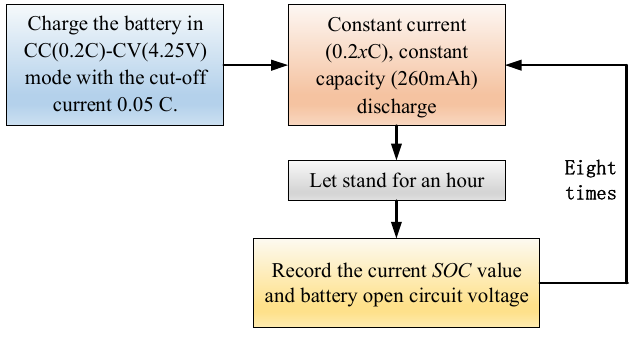
Figure 4. Calibration steps of the OCV-SOC . The corresponding relationships between OCV and SOC were recorded for x = 2, 3, 4, 5, 6, 7.5, 10, respectively. Figure 5 shows the different OCV-SOC relationships with sixth order polynomial fittings.